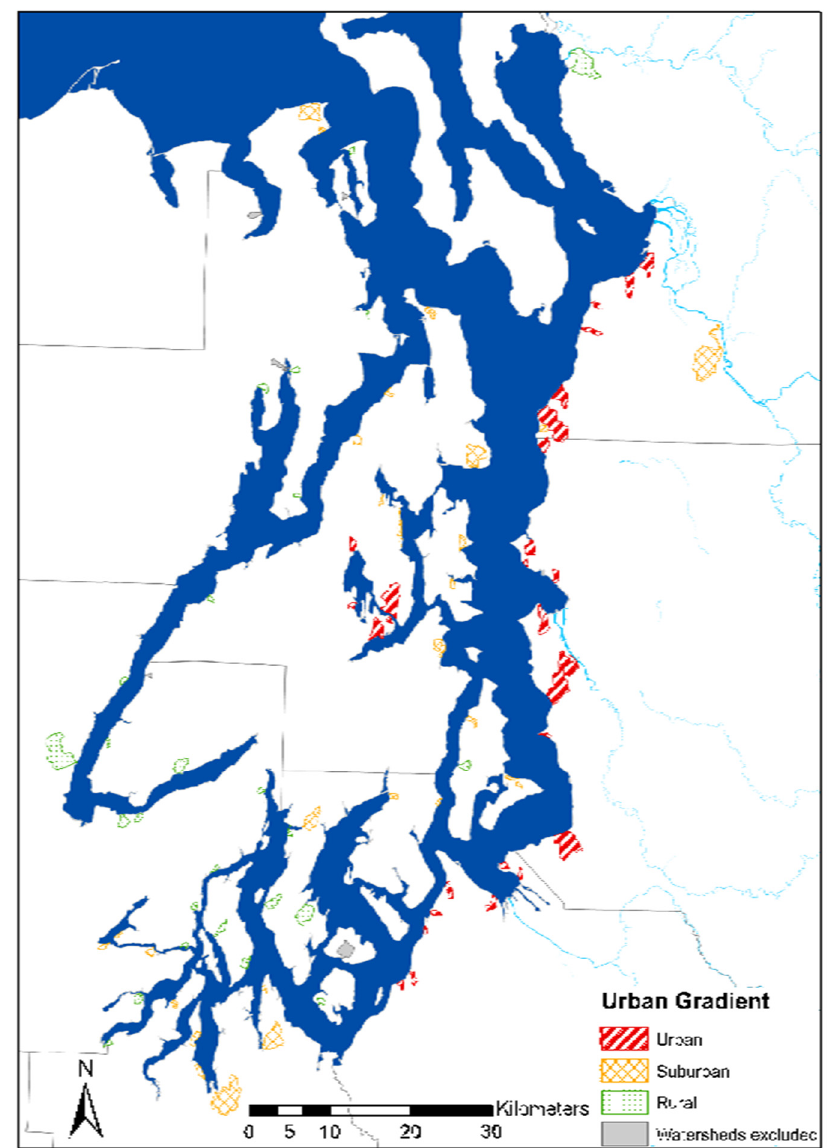
Figure 4. Location of 90 sampled coastal watersheds across the study area. Each watershed was classified as urban (30 watersheds), suburban (30 watersheds) and rural (30 watersheds). Five watersheds were removed from the sample because they lacked wastewater